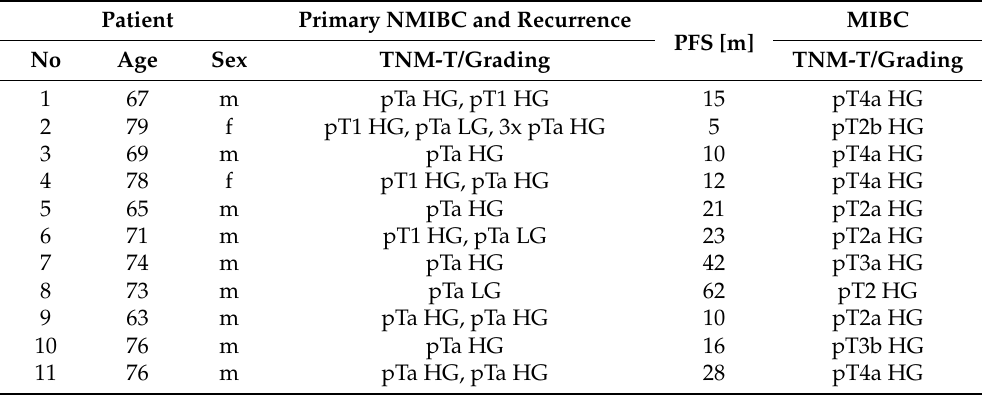
Table 1. Patient material and characteristics. NMIBC, non-muscle-invasive bladder cancer;